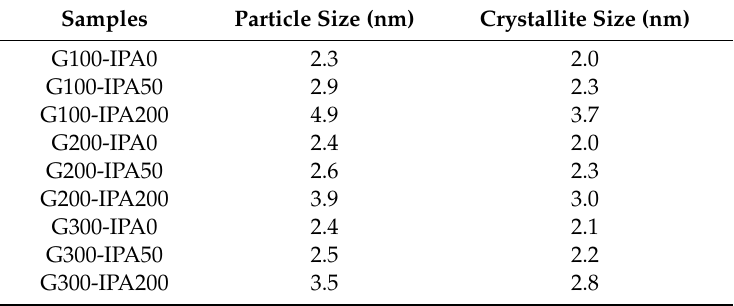
Figure 3. XRD patterns of Pt / C catalysts synthesized using di ff erent IPA contents (0, 50, and 200 mL) in fixed amounts of glycerol of ( A ) G100, ( B ) G200, and ( C ) G300. ( D ) Particle sizes of Pt / C catalysts according to the reaction conditions. Table 2. Particle and crystallite sizes, which were obtained from TEM and XRD analyses, respectively, of the samples synthesized under di ff erent